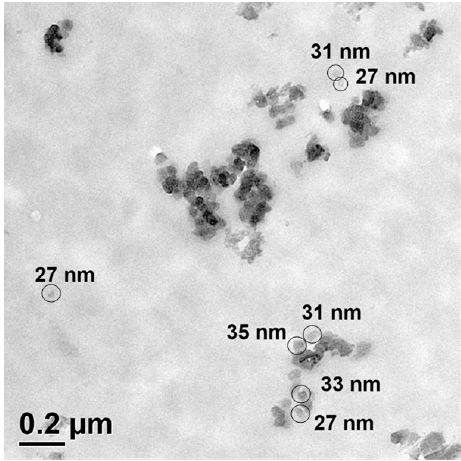
Figure 2. Transmission electron microscope image of silica particles dispersed in a matrix of a crosslinked copoly(2-oxazoline). crosslinked